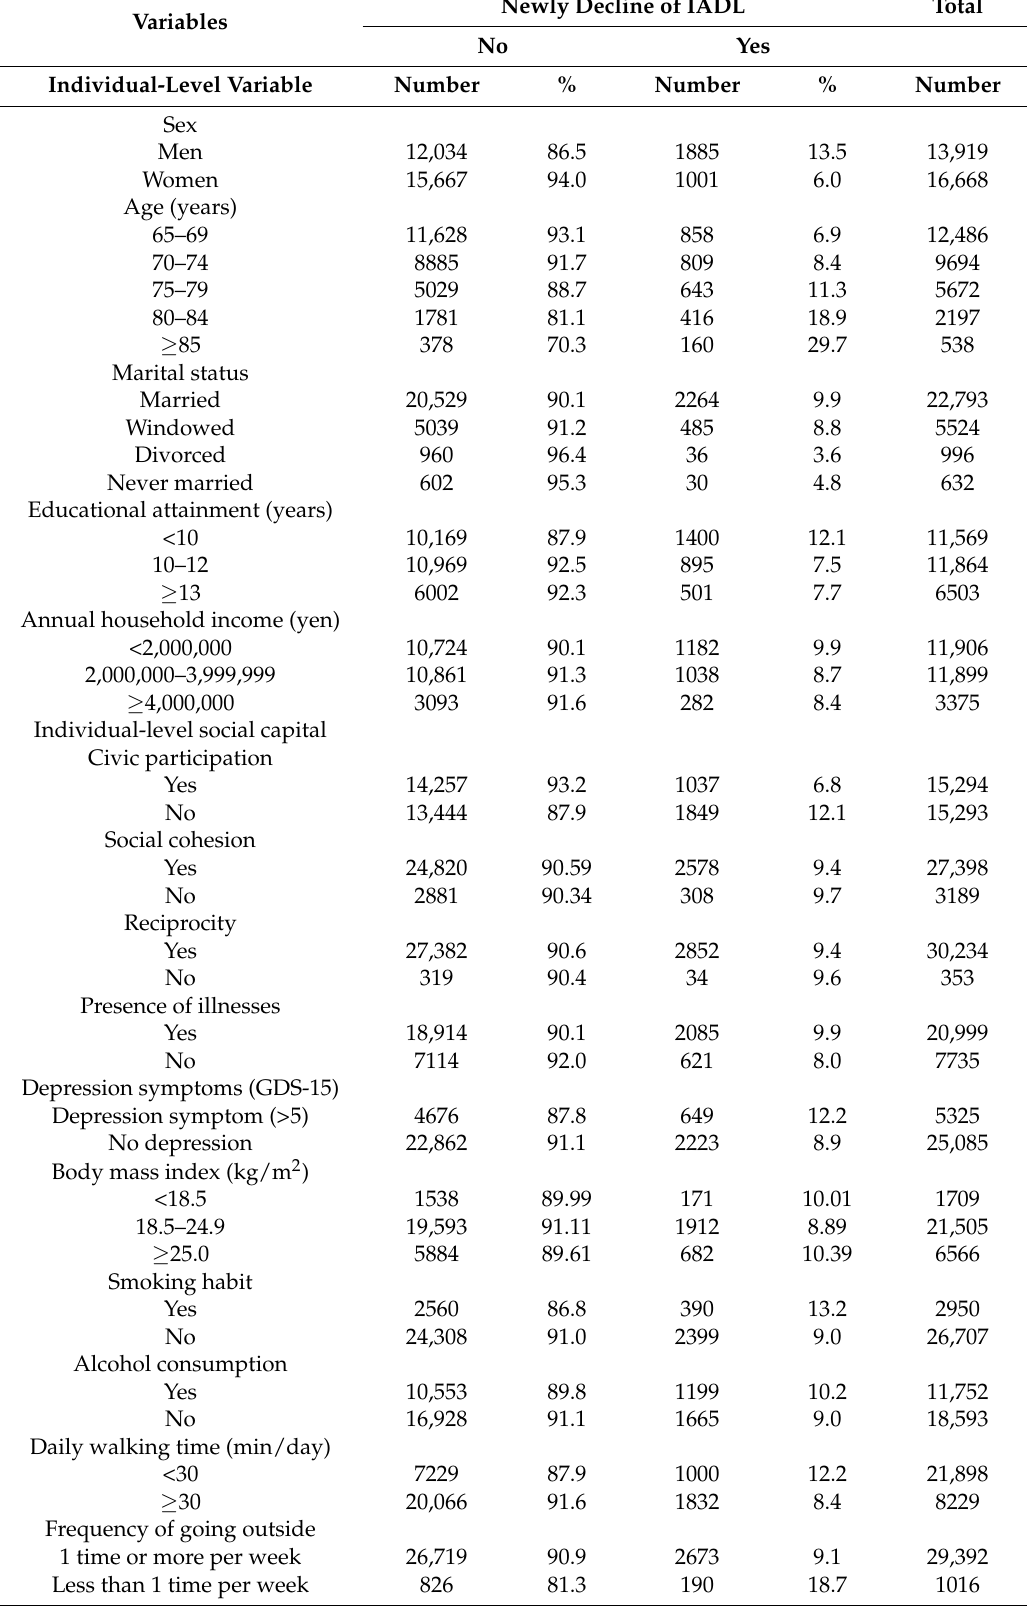
Table 1. Baseline characteristics of respondents and newly decline of IADL ( n = 30,587).